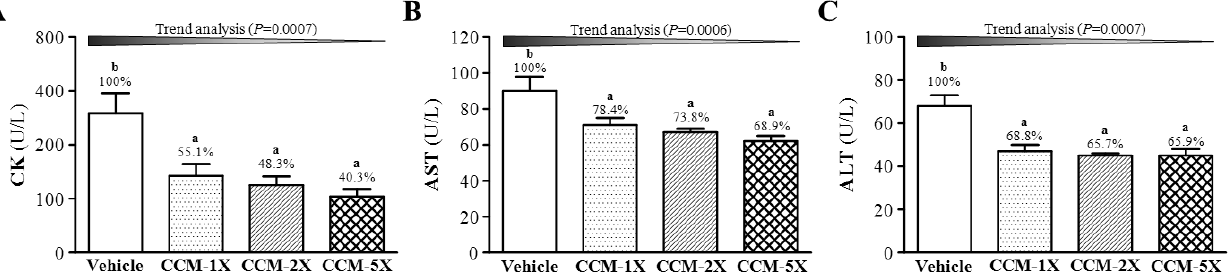
Figure 5. Effect of CCM supplementation on serum levels of ( A ) creatine kinase (CK); ( B ) aspartate transaminase (AST); and ( C ) alanine transaminase (ALT) after acute exercise challenge. Data are mean ± SEM for n = 10 mice in each group. Different letters indicate significant difference at p < 0.05 by one-way